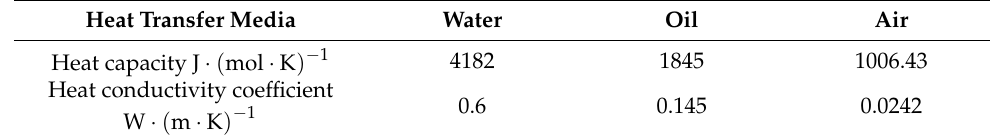
Table 3. Parameters of heat transfer media.